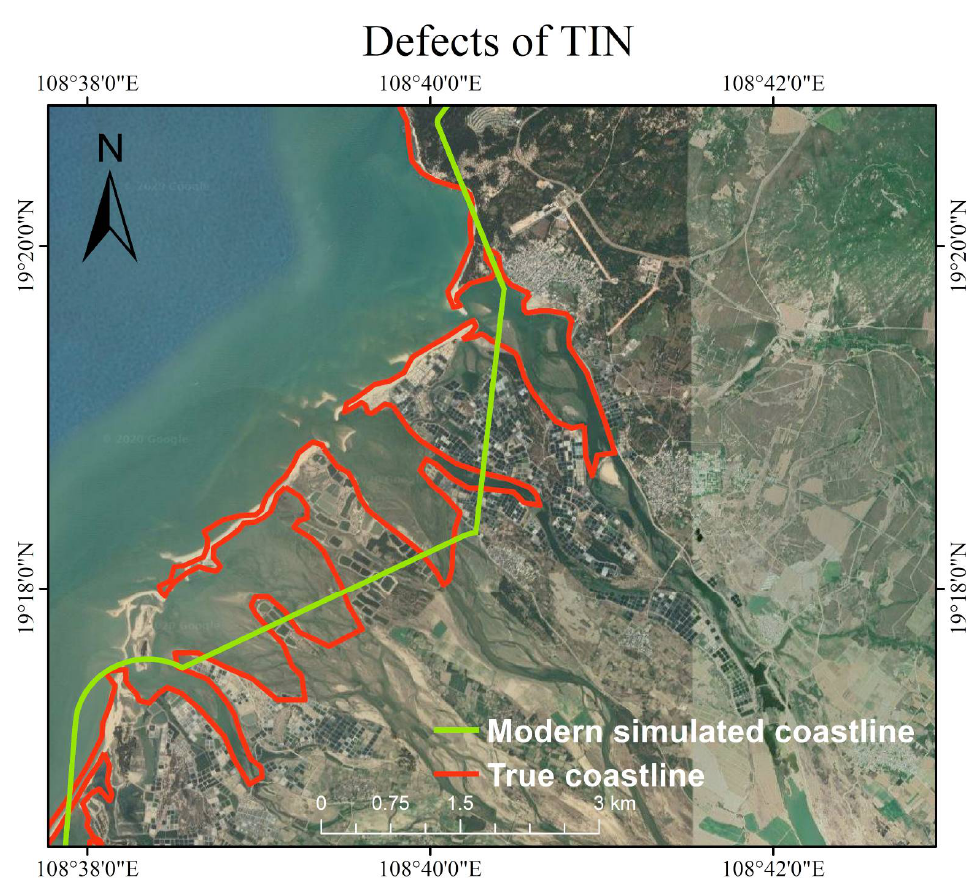
Figure 10. Defects of the method: the simulated coastline is poor in detail restoration of complex Figure terrain.